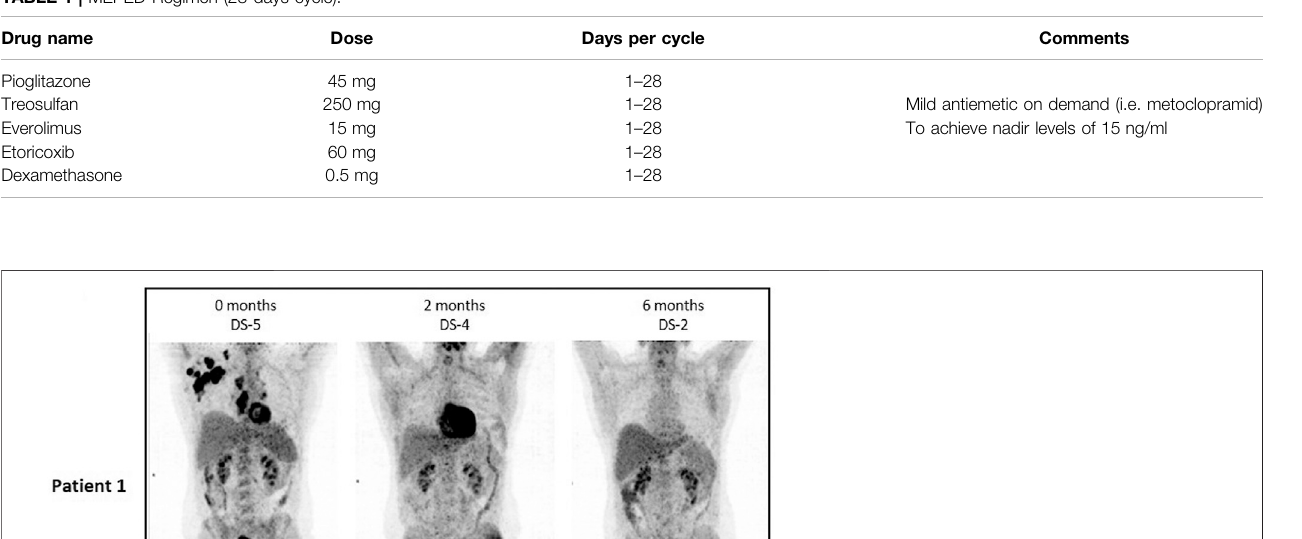
TABLE 1 | MEPED-Regimen (28-days cycle).